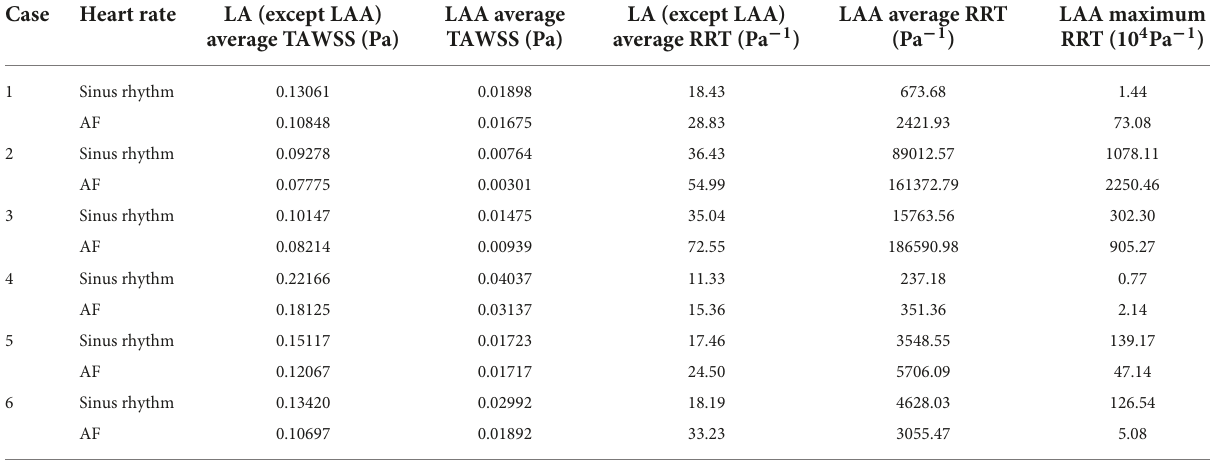
TABLE 2 Mean TAWSS, mean RRT at LA and LAA and maximum RRT at